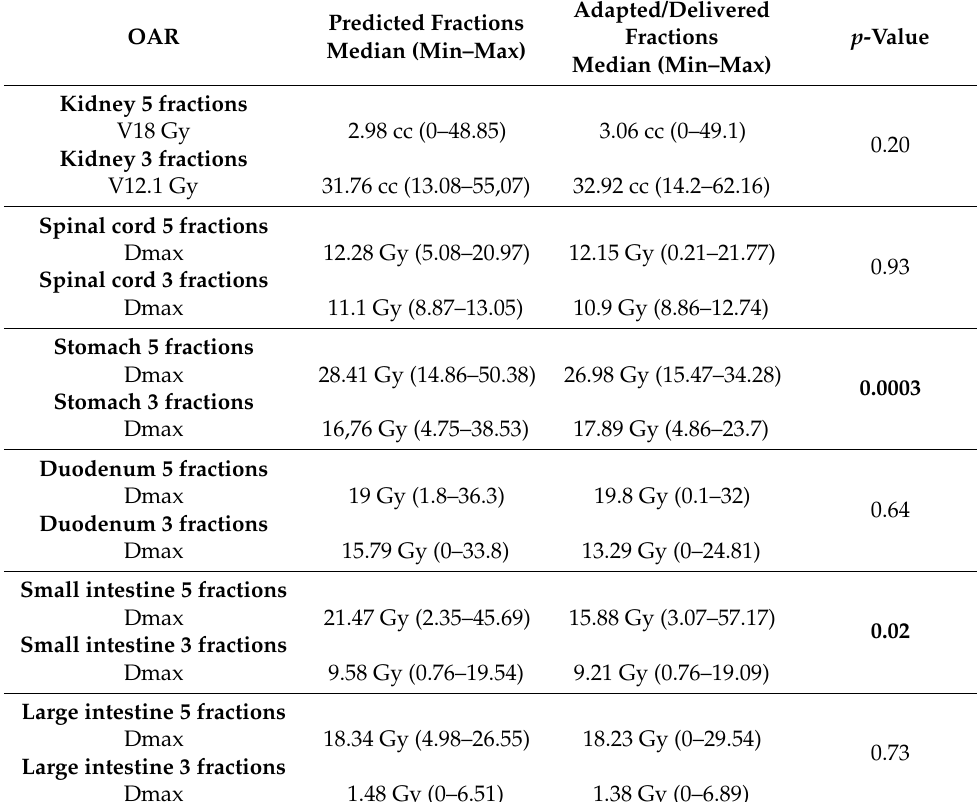
Table 5. OAR’s dosimetric results for the predicted and adapted/delivered plans.